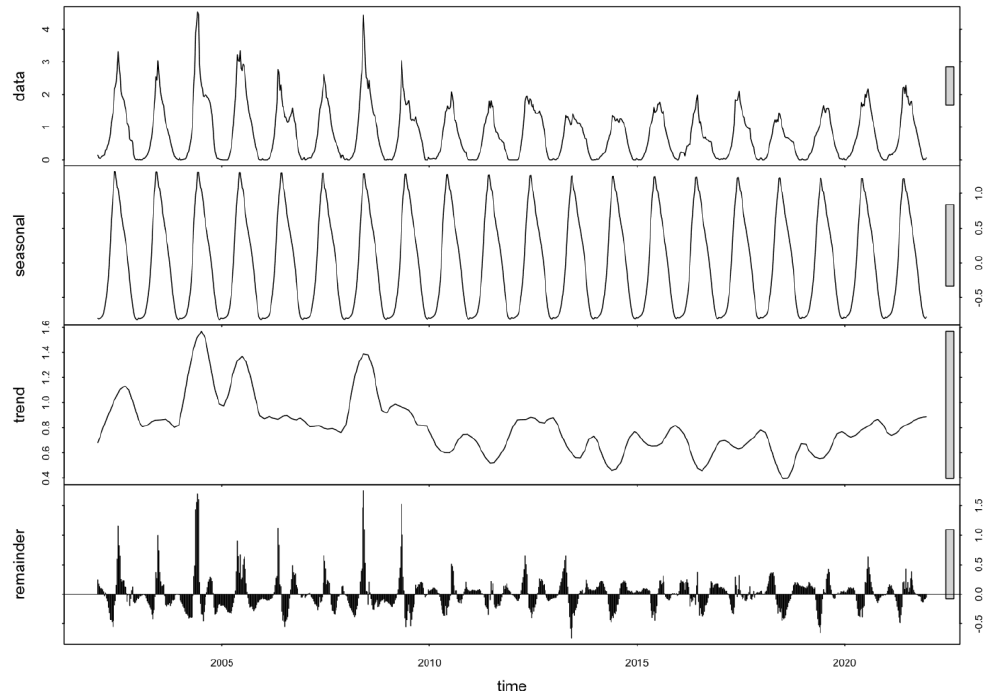
Figure 4. Example of STL seasonal decomposition for a grassland pixel (38°34′N, 101°45′E) during 2002 – 2021.